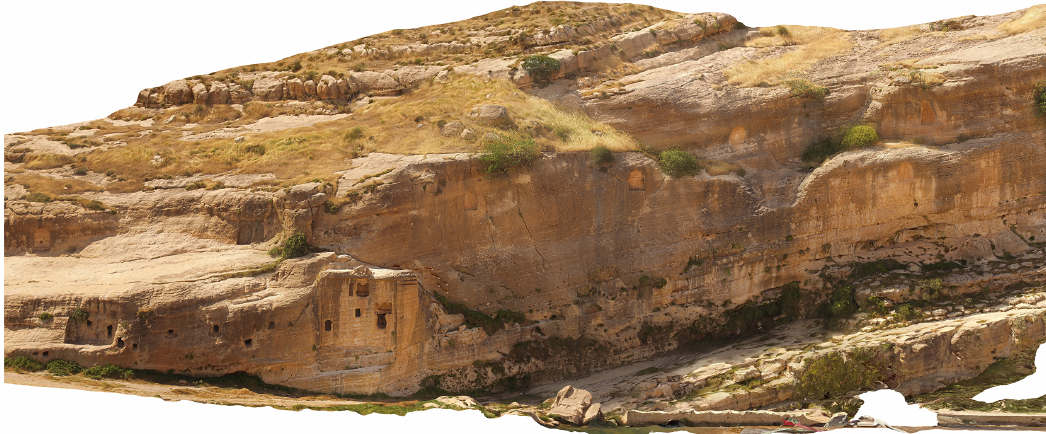
Figure 3. A view of the Khinis’ rock. On the left, the rider’s panel is the great bas-relief and, on the top, many different niches with Sennacherib’s